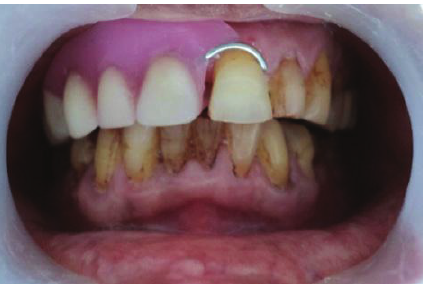
Figure 17: Prosthesis in patient’s